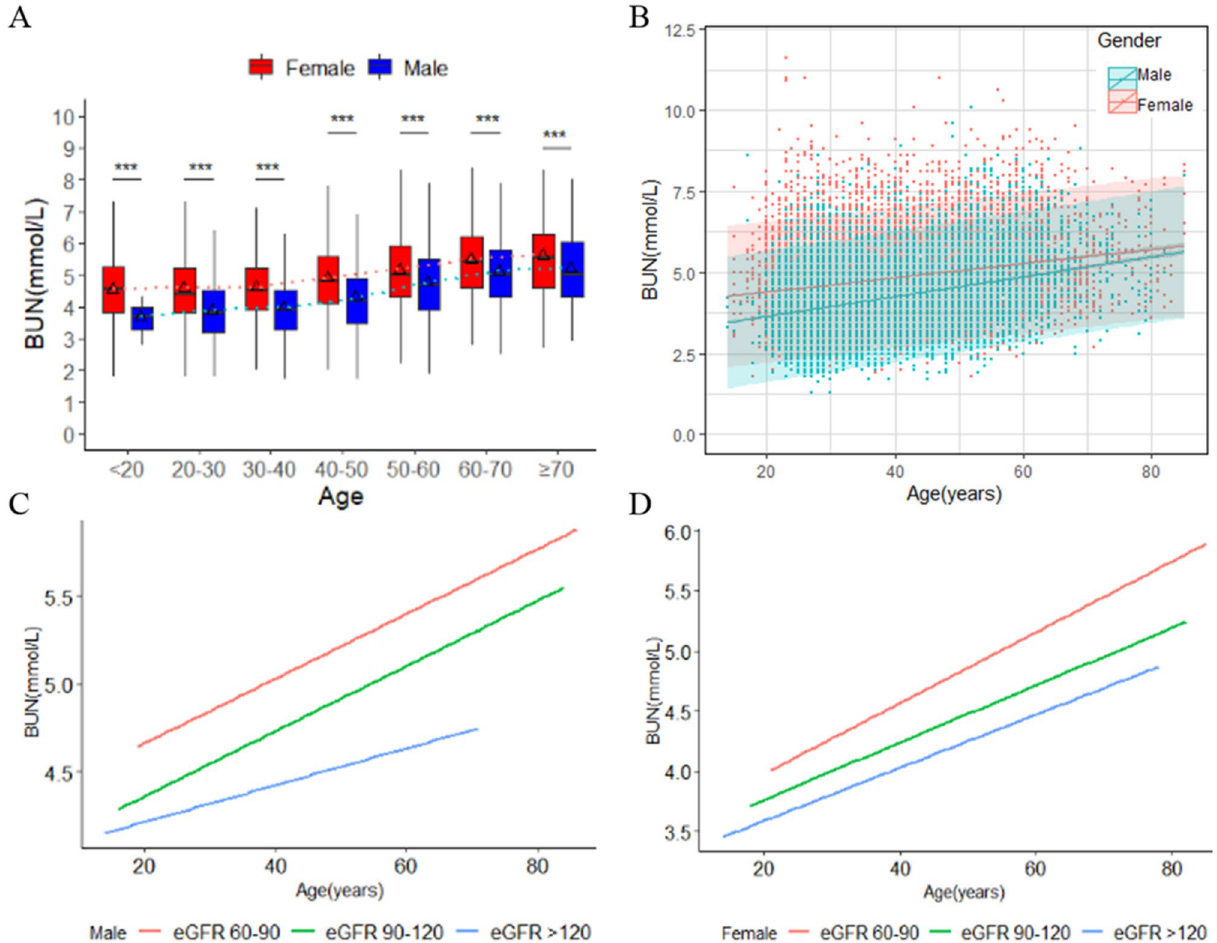
Figure 2. Sex-specific association between age and blood urea nitrogen (BUN). ( A ) Sex-specific boxes plots of BUN by age groups in males and females population. The black triangle in the box plots indicates the mean value. The dotted light red line represents the mean value line for each males age groups. The dotted light green line represents the mean value line for each females age groups. The definition of red boxes represent males population and blue boxes represent females population, ***P < 0.001. ( B ) Scatter plot of association between age and BUN by sex in males and females population. Solid lines express predicted BUN by age and sex with 95% prediction intervals (shaded area) for each sex. (C,D) Sex-specific associations between BUN levels and age by groups of estimated glomerular filtration rate (eGFR) in the males and females population assessed by linear